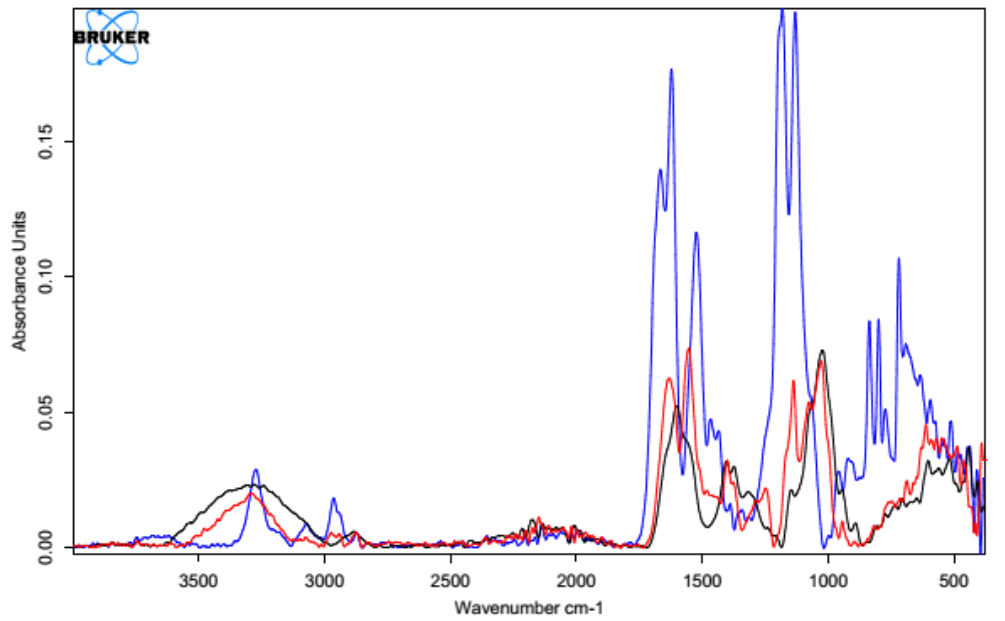
Figure 17. IR spectrum of native HA (black line) vs. HA–KRMVRISRSL conjugate (red line) and the spectrum of the used peptide (blue line).